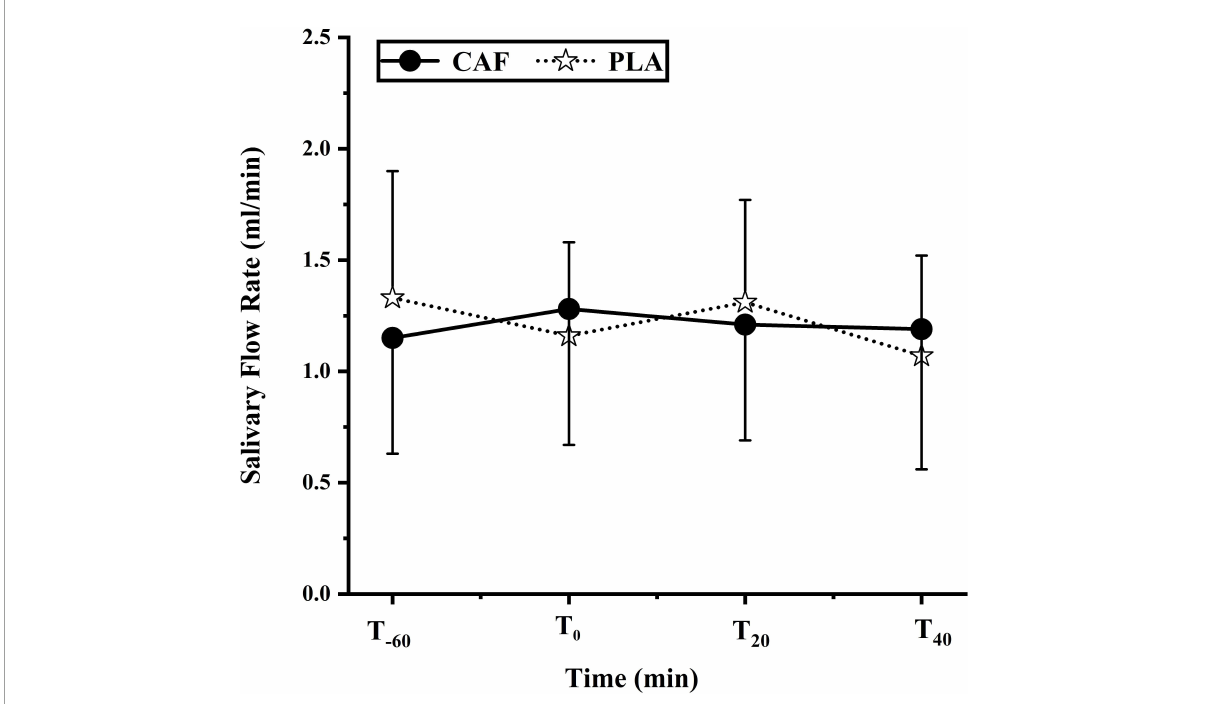
FIGURE3 Saliva flow rate during the two trials of the participants. Data are mean ± standard deviation ( n = 12).